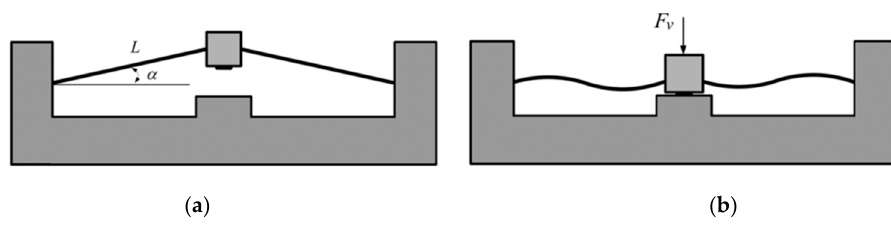
Figure 8. Postbuckling beams structure. ( a ) Original state. ( b ) Postbuckling state [40].